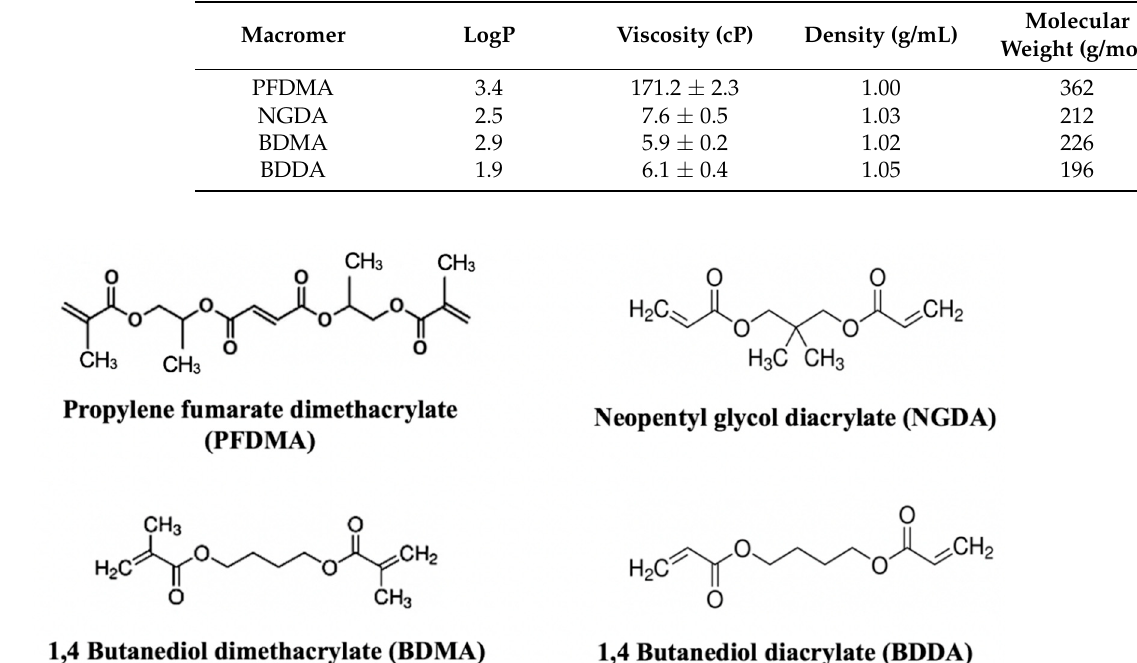
Figure 2. Molecular structures of PFDMA, NGDA, BDMA, and BDDA.